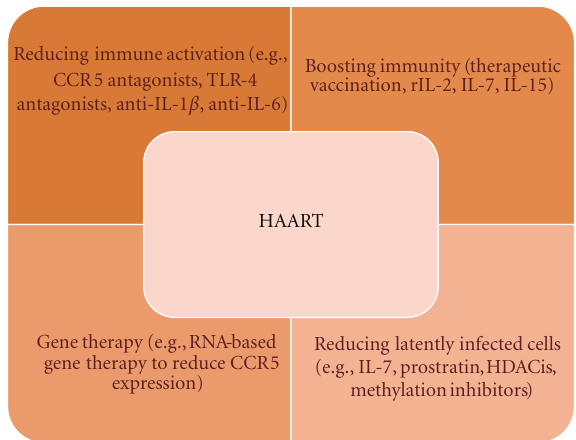
Figure 2: Therapeutic options for increasing CD4+ T-cell